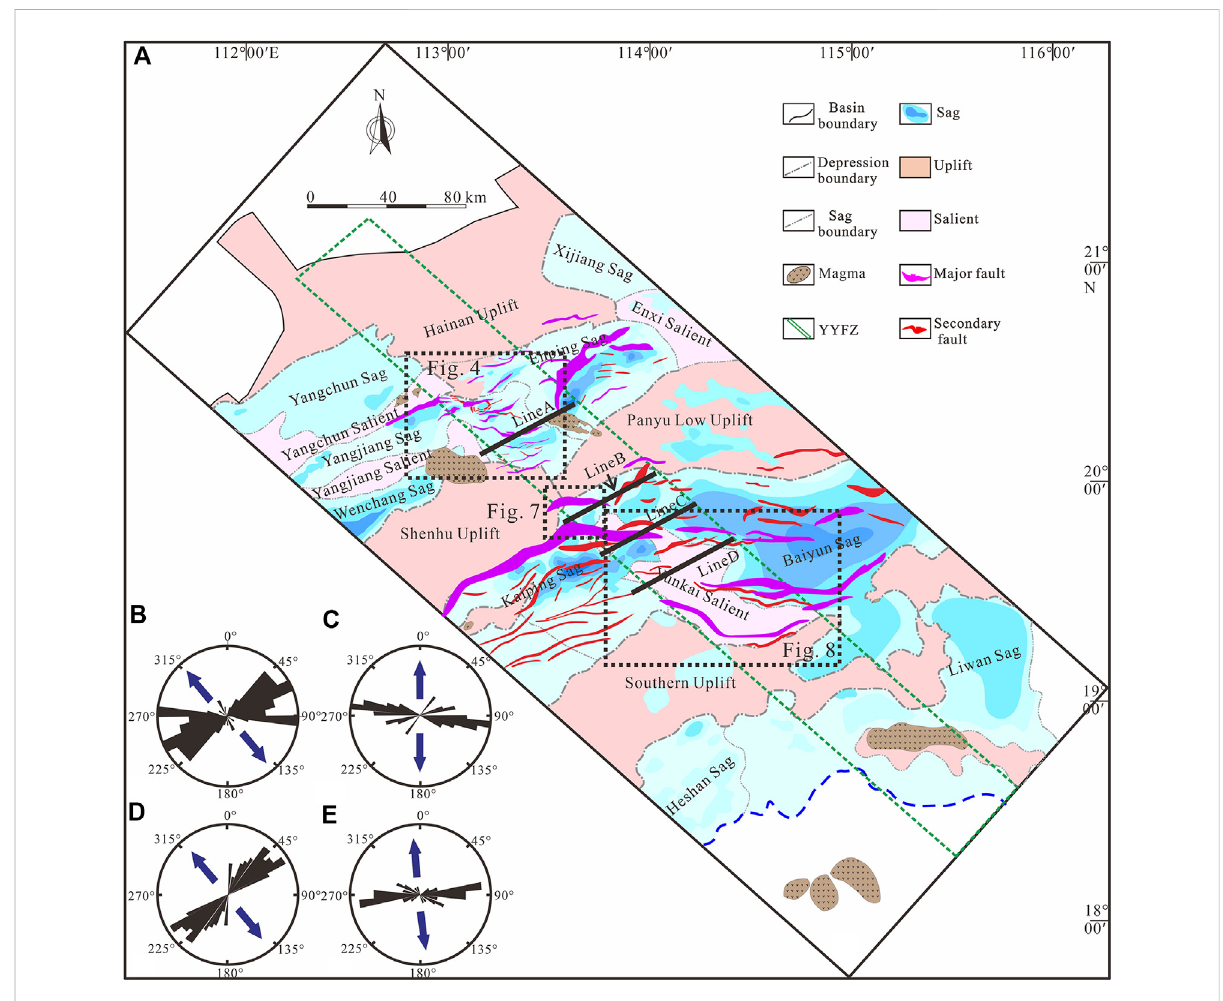
FIGURE 2 (A) TectonicframeworkofthestudyareaandthelocationoftheYYFZ. (B – E) arethestrikerosediagramsofmajorfaultsintheYangjiang,Enping, Kaiping, and Baiyun sags,